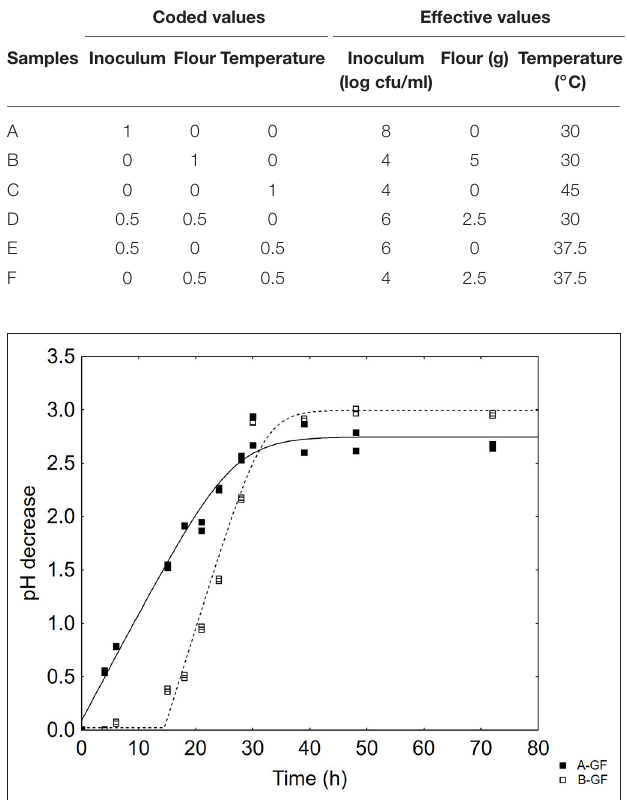
FIGURE 1 | Acidification of L. delbrueckii subsp. bulgaricus in two selected combinations of the design. The lines represent the best fit through the lag-exponential equation. GF, Gluten Friendly